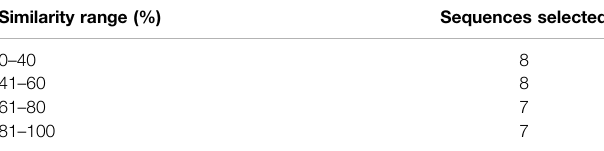
TABLE 1 | Sequences selected for phylogenetic analysis of STEAP2 by MSA. Similarity range